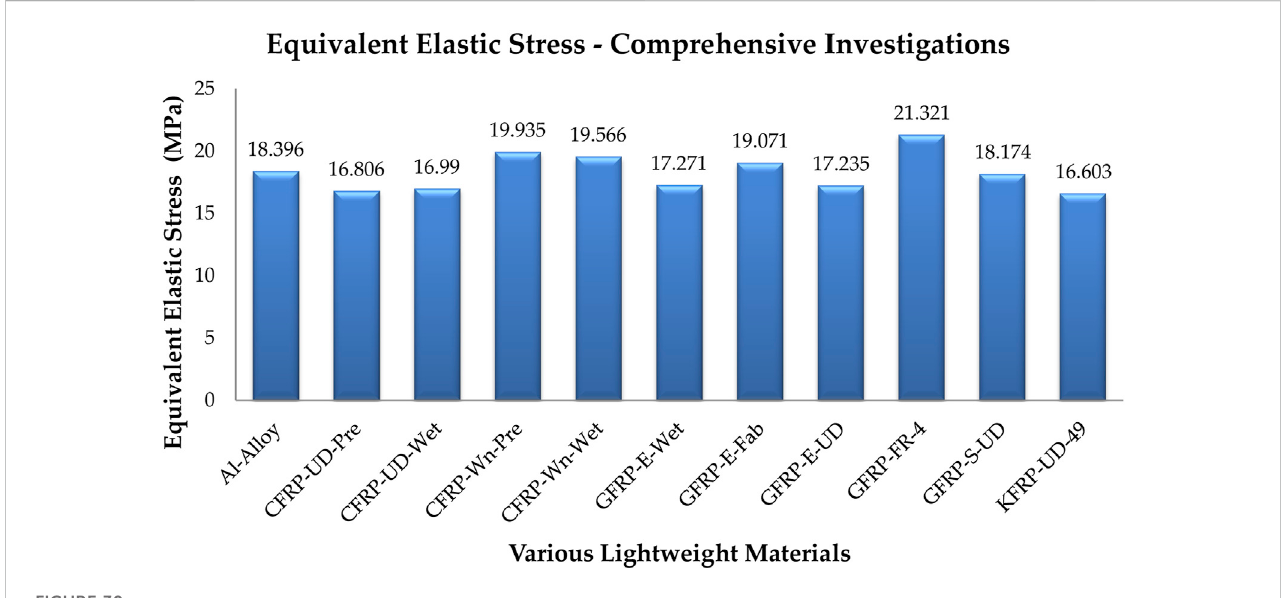
Comprehensive report of equivalent elastic stress of